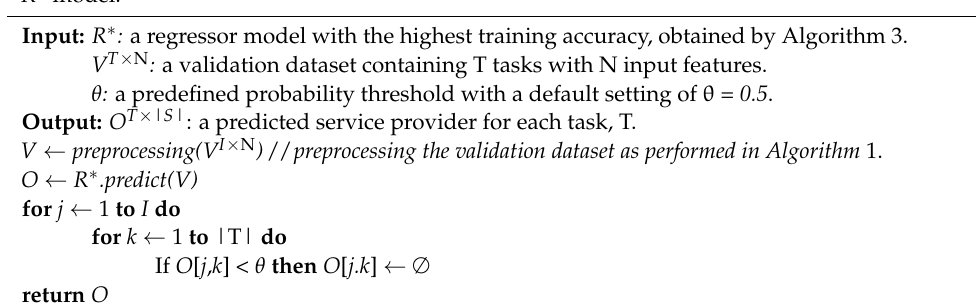
Algorithm 4: Validation procedure to predict the best service provider, S i , for each task, T i , using R ∗